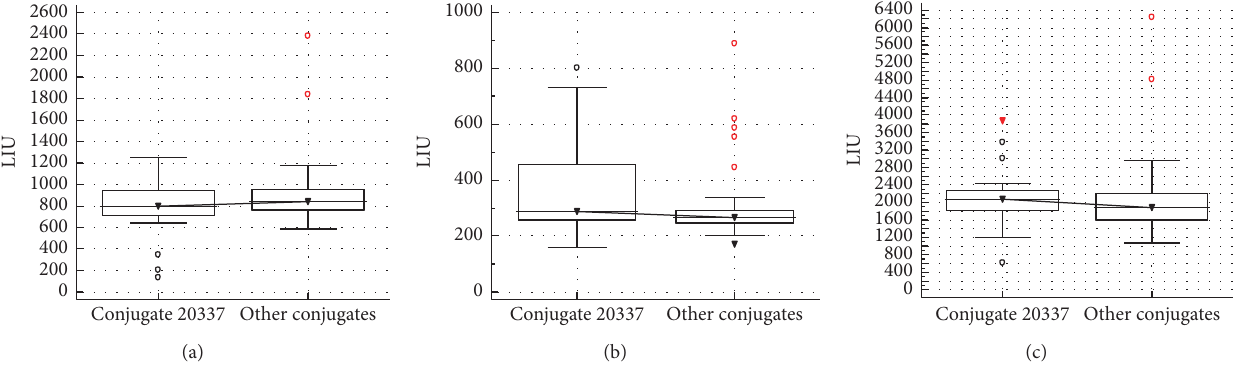
Figure 4: Results of LIU variability for laboratories using conjugate lot number 20337 and laboratories using other conjugate lot numbers for samples 1, 2, and 3 ((a), (b), and (c), resp.).